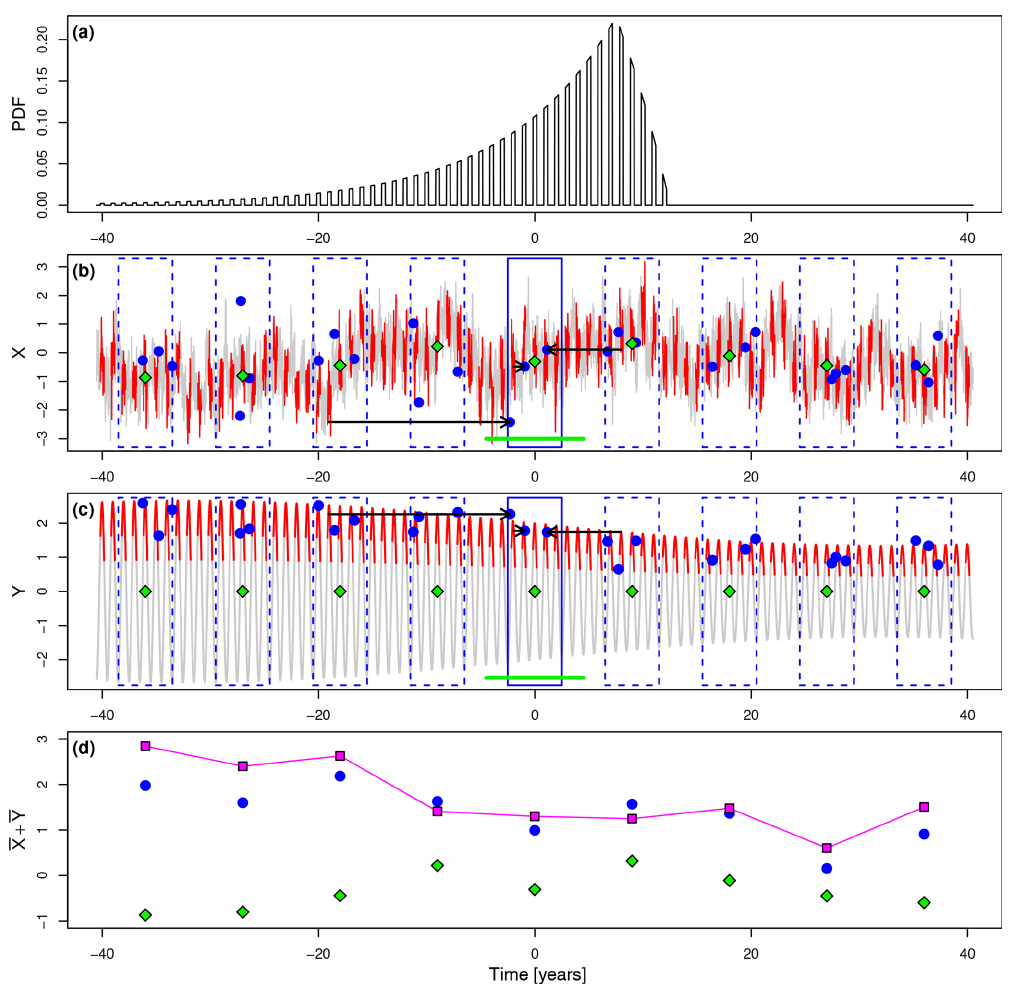
Figure 1. Schematic illustration of the reconstruction uncertainty model. (a) Probability density function (as a function of time lag) that describes the combined effects of bioturbation (with timescale τ b ), of sediment sample thickness, and of proxy seasonality. (b) Stochastic component X ( t ) of the climate signal (gray line) with dates highlighted in red that fall into the proxy abundance window (of length τ p ) to reflect proxy seasonality. Blue rectangles indicate time intervals of length τ s covered by the sediment slices. From each slice a finite number of signal carriers ( N = 3 in this example) are retrieved from random positions within the slice indicated by the blue dots, each of which carries the signal from the time at which it settled down on the surface of the sediment before it was mixed to its current position by bioturbation (indicated by black arrows for the central slice). Green squares indicate the reference climate signal obtained by averaging X ( t ) over intervals of length τ r as indicated by the green line for the central point. (c) Same as (b) but for the deterministic component Y ( t ), which represents the amplitude modulated seasonal cycle. (d) Total reconstructed signal (blue) obtained by averaging over the N signal carriers from each slice, reference climate signal (green), and the difference between them (magenta) that represents the reconstruction error at a sampling interval (cid:49)t . Measurement errors are neglected in this illustration. Timescale parameters are set to τ b = 10 years, τ s = 5 years, τ r = 9 years, (cid:49)t = 9 years, and τ p = 1 / 3